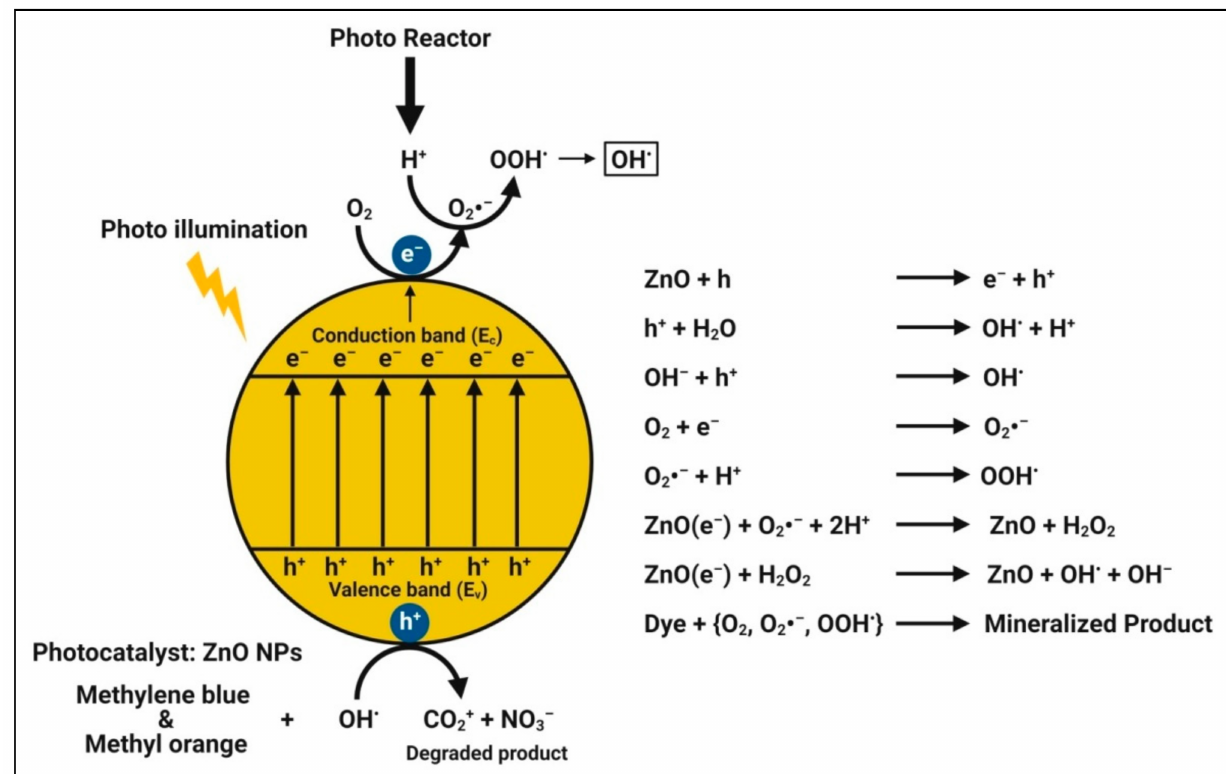
Figure 7. Possible photocatalytic mechanism of plant-mediated zinc oxide